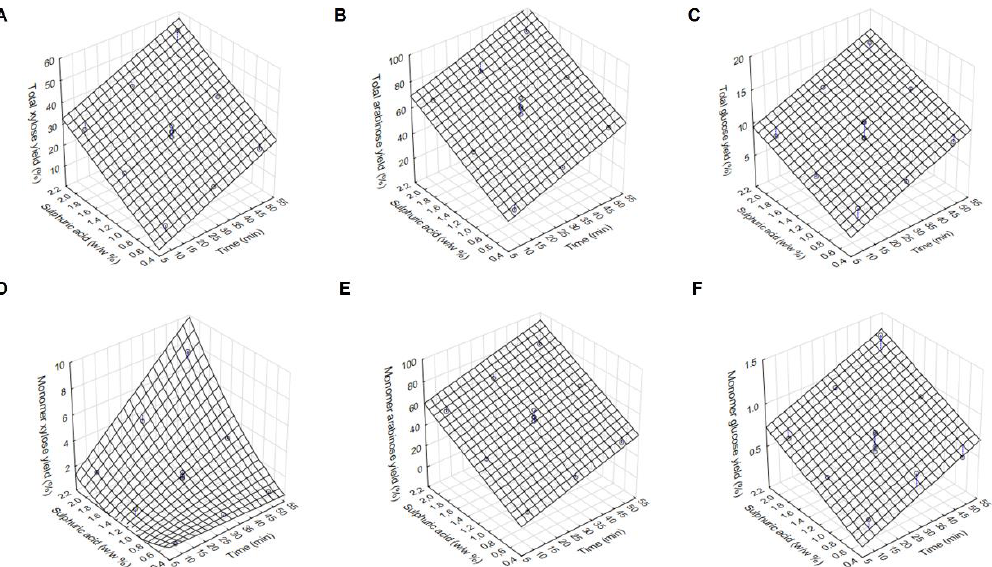
Figure 1. Fitted surfaces of the total xylose yield ( A ), total arabinose yield ( B ), total glucose yield ( C ), monomer xylose yield ( D ), monomer arabinose yield ( E ), and monomer glucose yield ( F ). Scales are fitted according to the maximum value of each response variables.